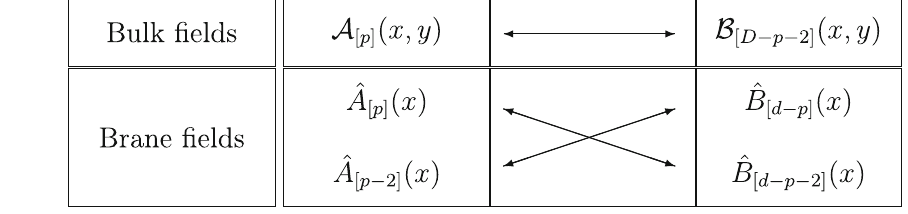
Fig. 2 Equivalency relation (indicated by the arrows) between the bulk fields, and also, between the effective brane fields after the dimensional